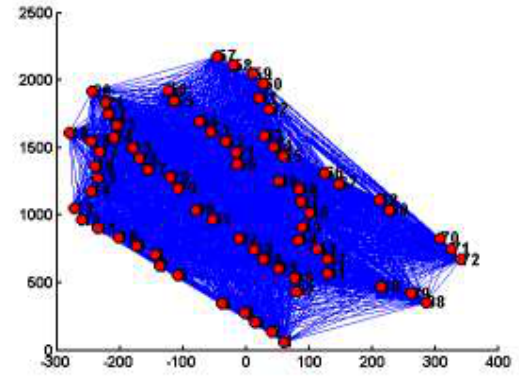
Fig. 6 Image graph with a traversal matching strategy